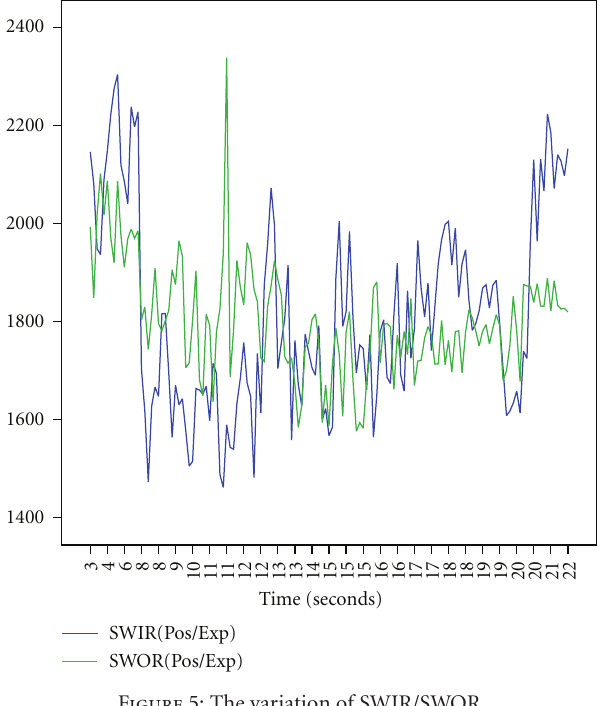
Figure 5: The variation of SWIR/SWOR.